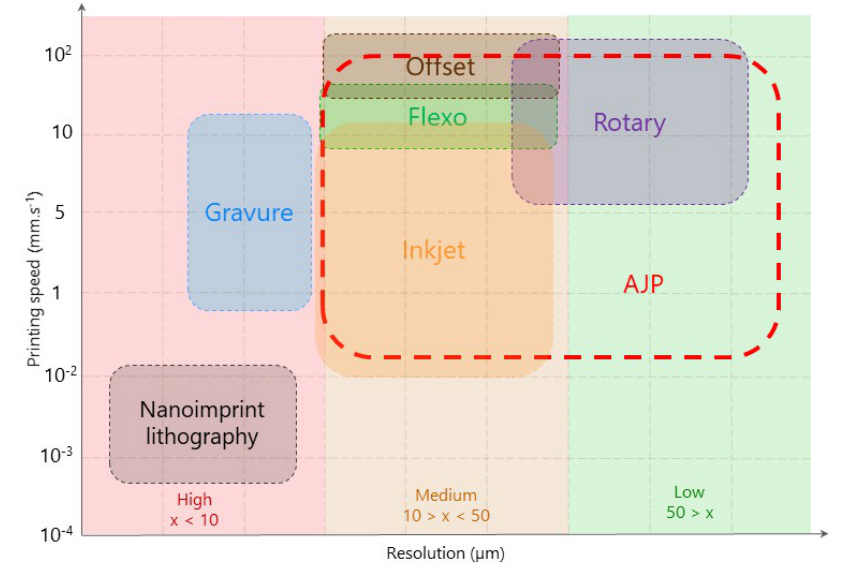
Figure 1. Printing speed and resolution of some popular printing techniques. (Adapted from Wu (2017) [7] with